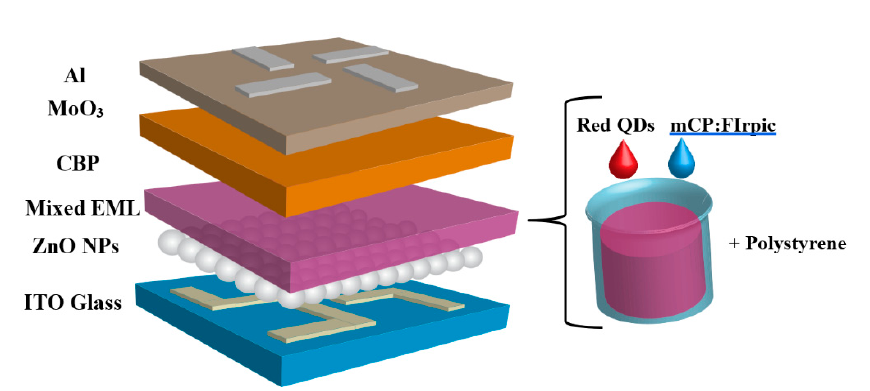
Figure 2. Schematic of hybrid electroluminescence (EL) devices with mixed emission layers (EMLs) of red quantum dots (QDs) and blue small molecules.